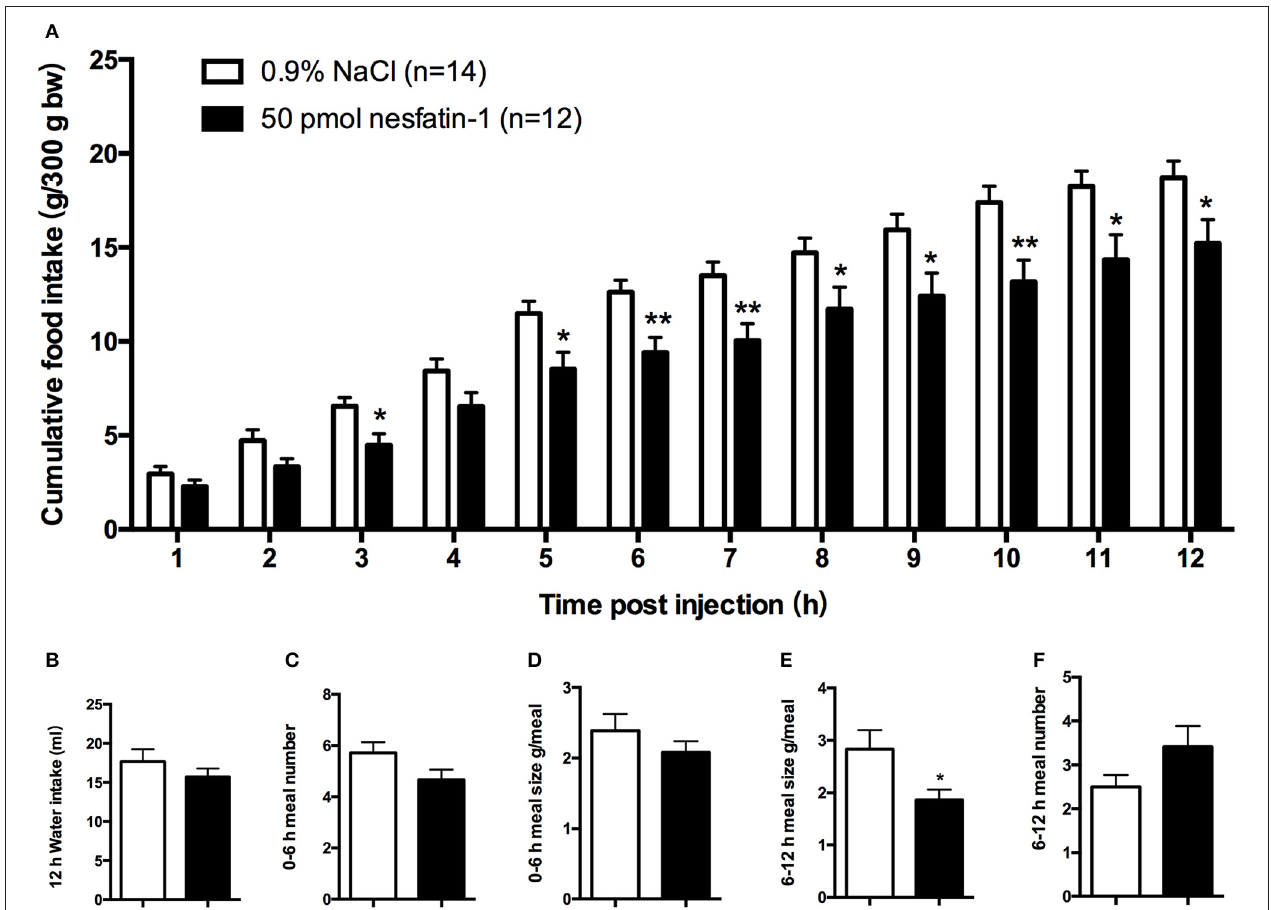
FIGURE 1 | Feeding responses to injections of nesfatin-1 in the LPBN. Nesfatin-1 injections (50 pmol) into the LPBN decreased cumulative food intake from 3 to 12 h after injection (A) without affecting 12-h water intake (B) . Nesfatin-1 (50 pmol/0.5 µ l) or vehicle was microinjected into the LPBN of ad libitum -fed mice at the onset of the dark phase, and meal numbers at 0–6 h (C) , meal sizes at 0–6 h (D) , meal sizes at 6-12 h (E) , and meal numbers at 6–12 h (F) were assessed using an automated food intake-monitoring device. Bars represent the mean ± SEM of 12–14 rats/group. * P < 0.05, ** P < 0.01 vs. saline vehicle-injected controls.